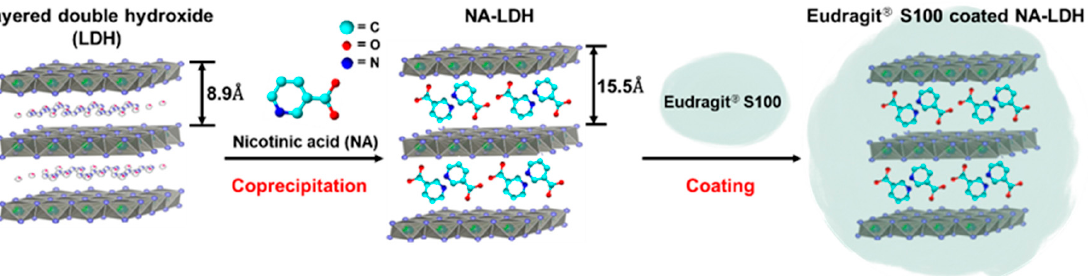
Scheme 1. Schematic for the NA molecules intercalated in the LDH layer via coprecipitation reac-